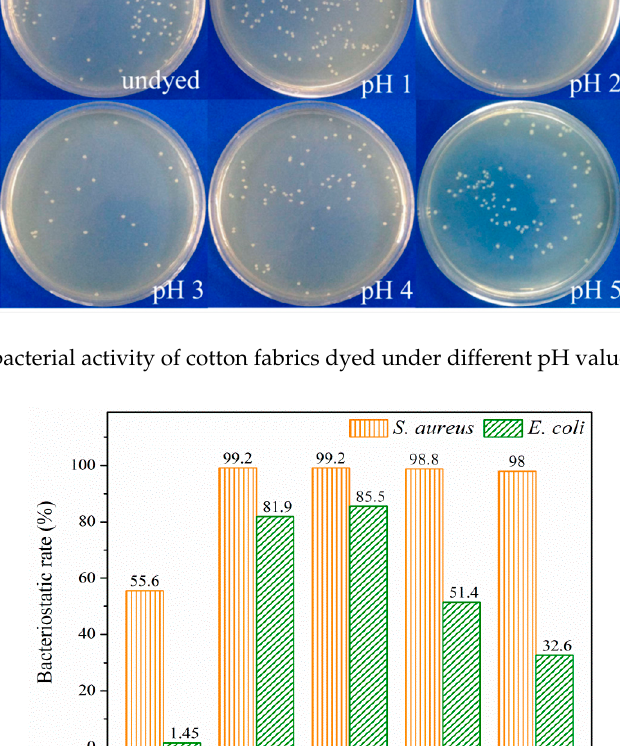
Figure 10. Antibacterial activity of cotton fabrics dyed under different pH values against E. coli .